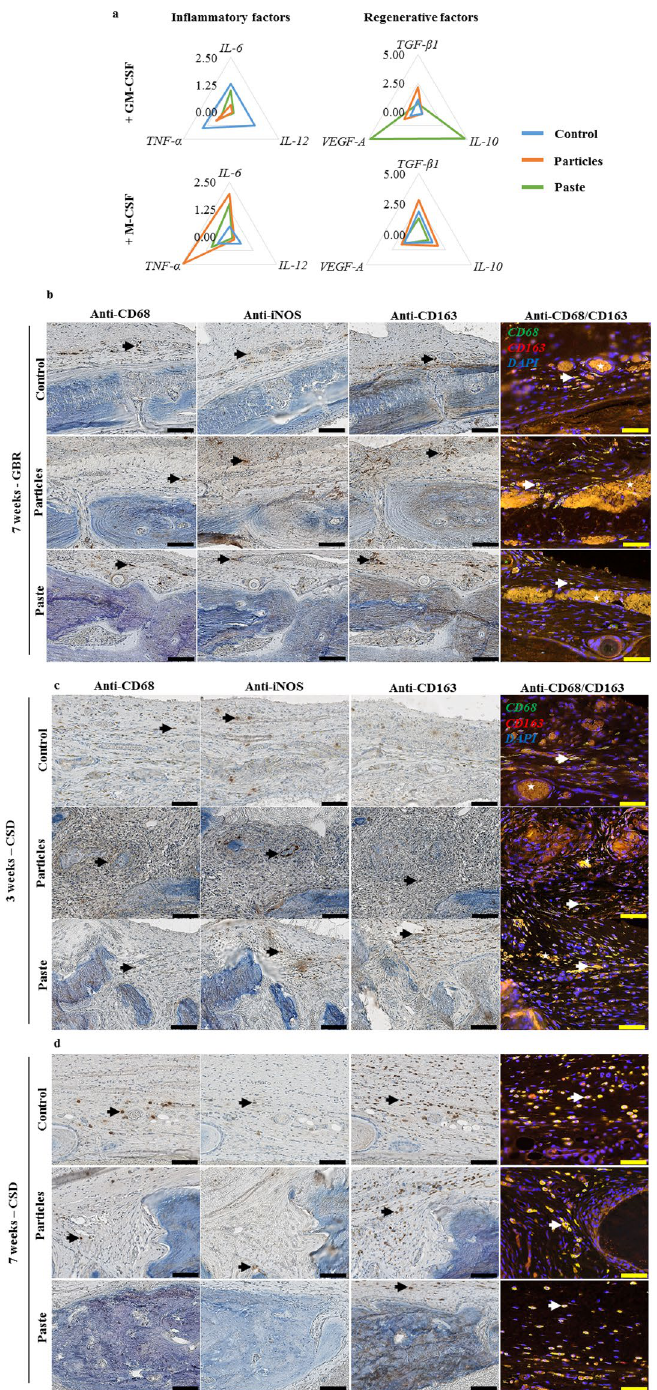
Figure 6. Effect of the particular bone graft and the bone paste on monocyte/macrophage polarization. ( a ) mRNA expression in human monocytes cultured in the presence of GM-CSF or M-CSF for 3 days in contact with the particular bone graft or the bone paste. The Y-axis represents the mean relative mRNA expression level of the specified genes (N = 3). Representative immunohistochemical and immunofluorescent stainings on successive undecalcified 7-µm thick sections, ( b ) in the GBR model after 7 weeks, and ( c ) in the CSD model after 3 and 7 weeks. Immunohistochemical stainings were performed for CD68, iNOS, CD163, and immunofluorescence with double labeling of CD68 (green)/CD163 (red) and DAPI (blue) for the nuclei. For single labeling, positive cells were stained with a brown precipitate (black arrow), for double labeling, double- positive cells appeared as light yellow (white arrow). Typical auto fluorescent red blood cells were visible (white stars). Scale bars: 100 µm for the immunohistochemistry, 50 µm for the immunofluorescence